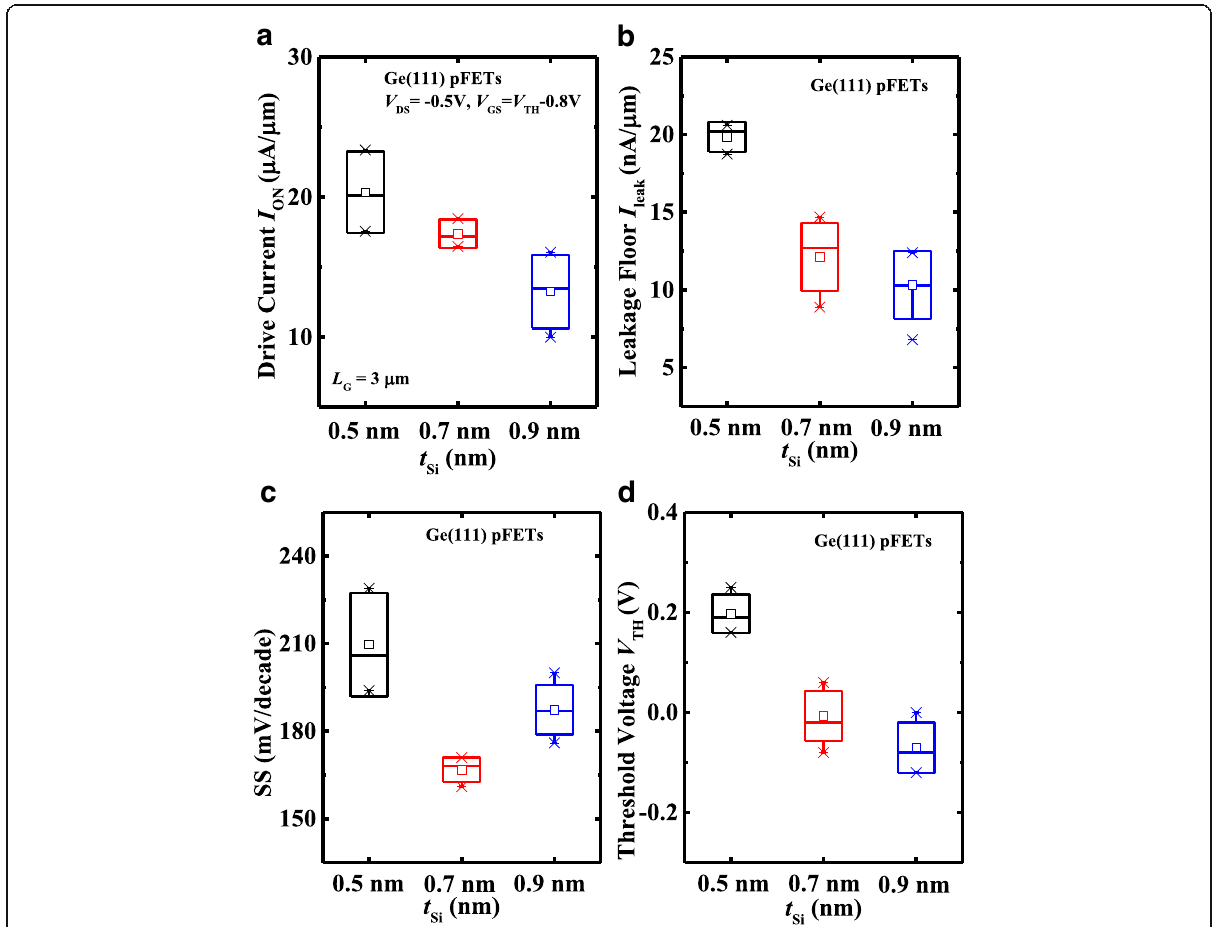
Fig. 8 Comparison of a I ON , b I leak , c SS, and d V TH for (111)-oriented Ge pMOSFETs with 0.5, 0.7, and 0.9 nm t Si showing that transistors with 0.5 nm t Si have the better I ON , but worse SS and I leak characteristics in comparison with devices with thicker t